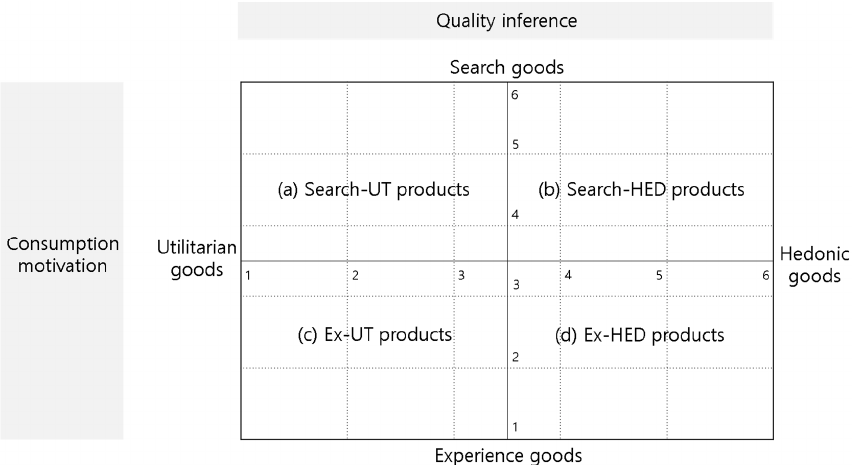
Figure 2. Classification of product type categories based on consumption motivation and quality inference.